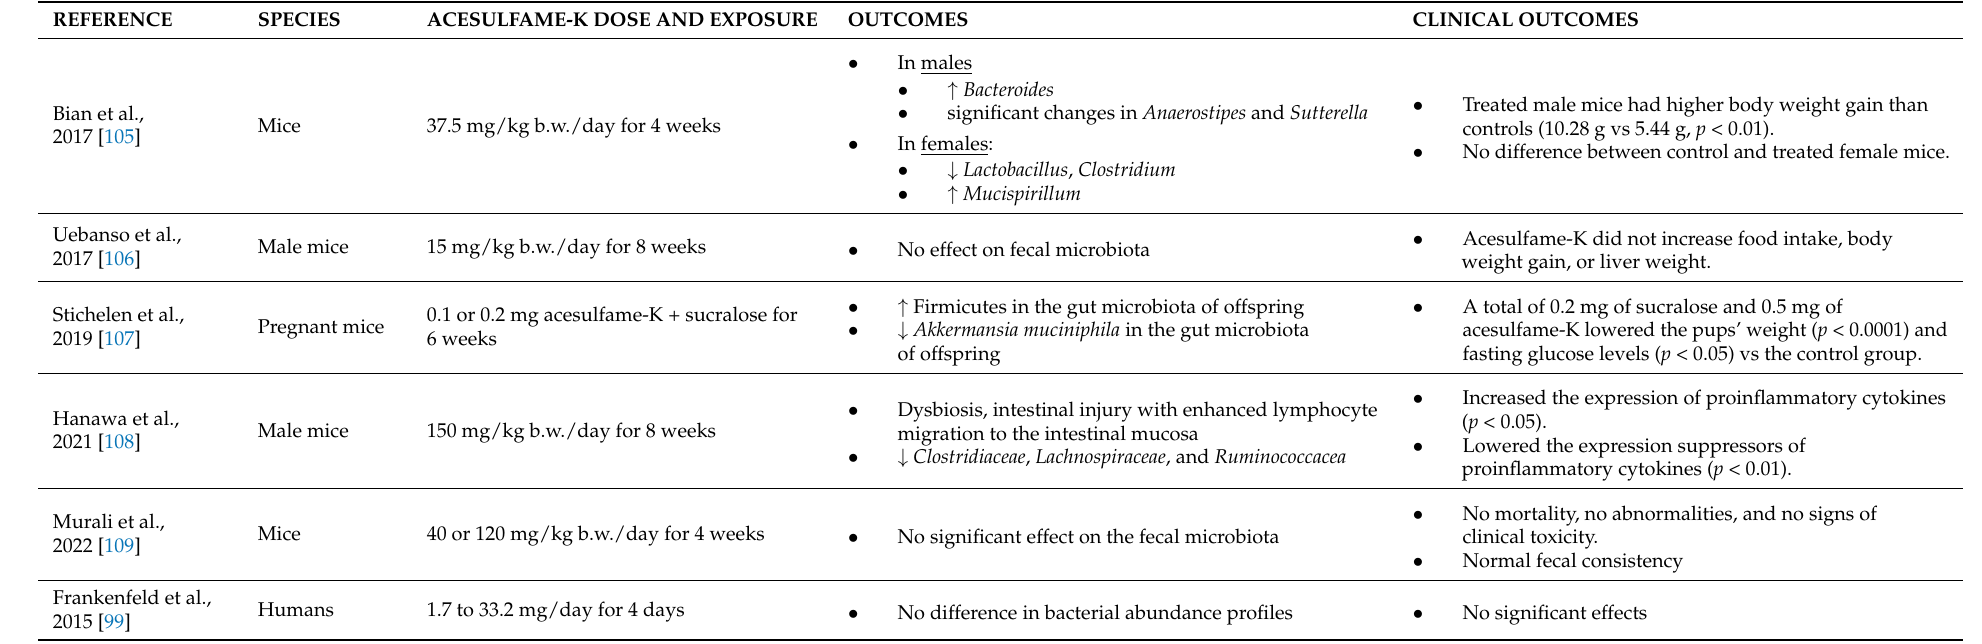
Table 3. Studies evaluating the effect of acesulfame-K on the gut